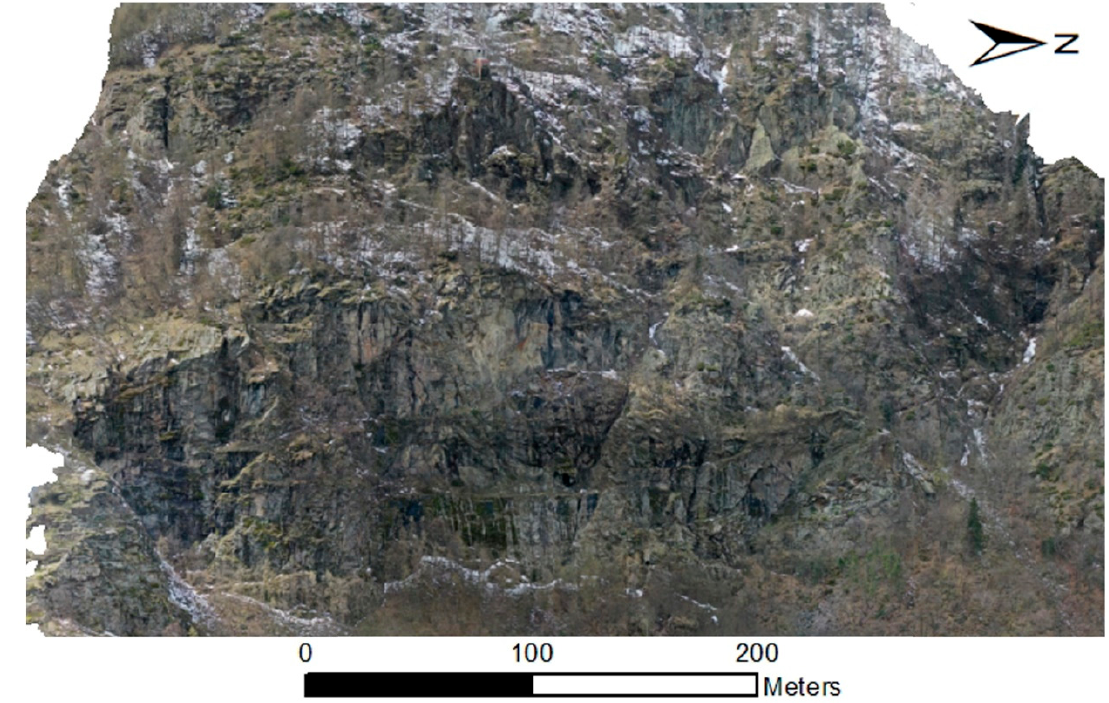
Figure 7. Example of the orthophotomosaic in frontal view.